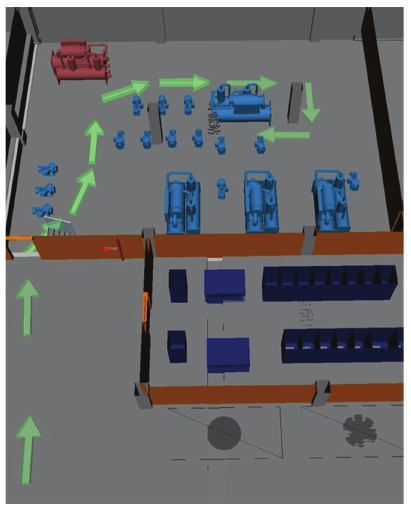
Figure 9: Optimal maintenance travelling path.